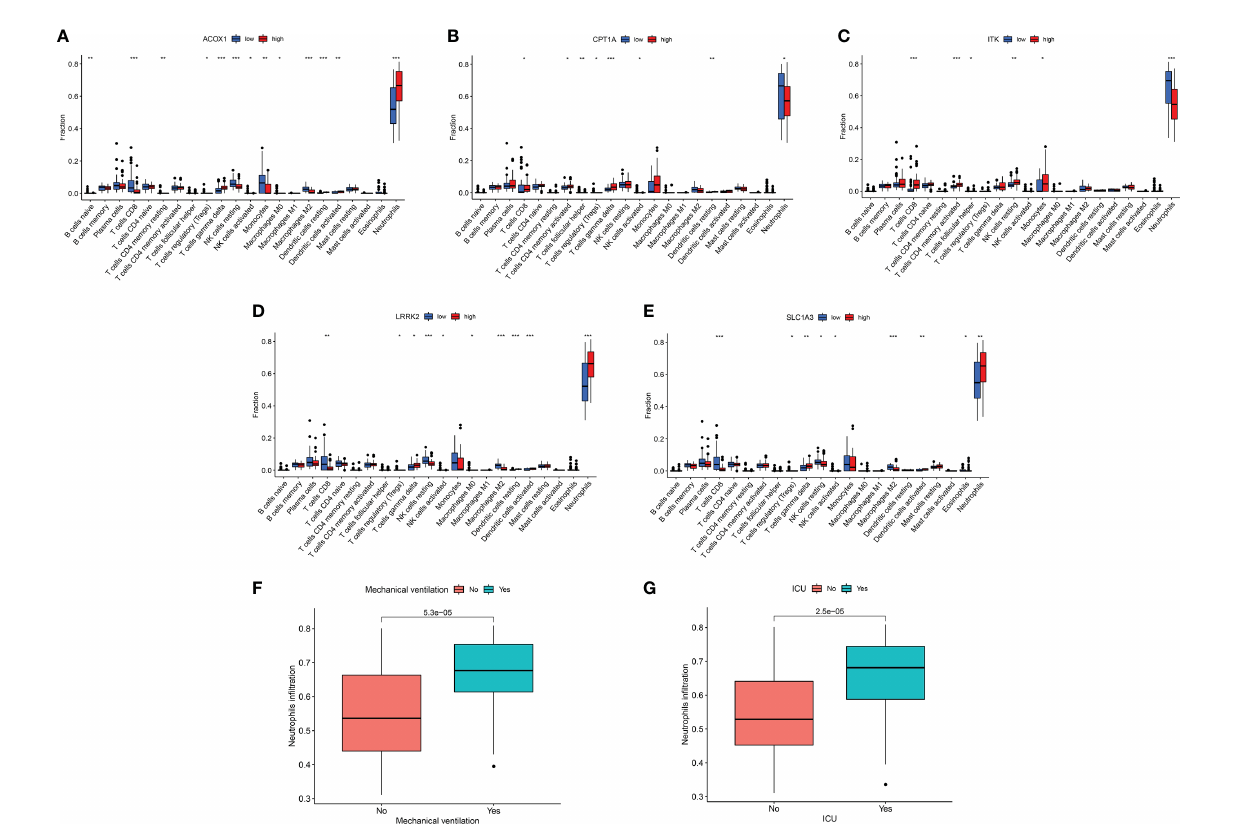
FIGURE 7 Immune response of target genes for COVID-19 patients. (A – E) Boxplot of target genes associated with 22 immune cell in fi ltration. (F) Boxplot of neutrophil in fi ltration associated with mechanical ventilation. (G) Boxplot of neutrophil in fi ltration associated with ICU admission. * p < 0.05, ** p < 0.01, *** p <